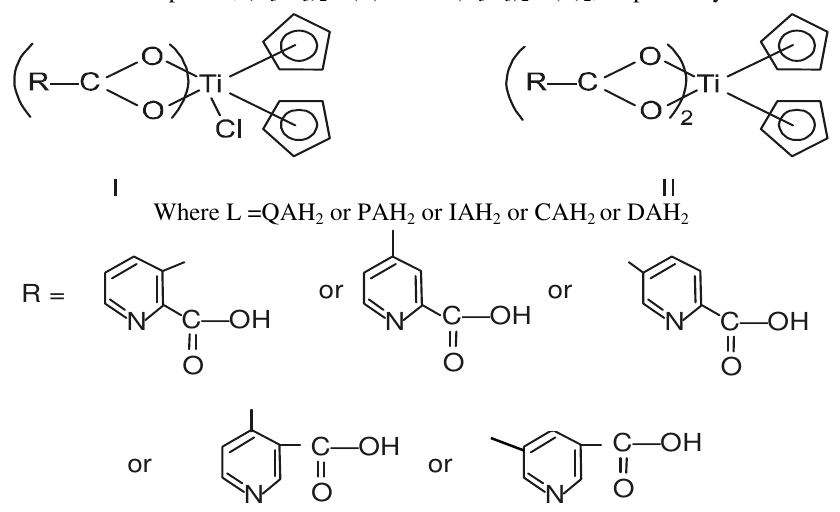
Figure 2. Proposed structure of the